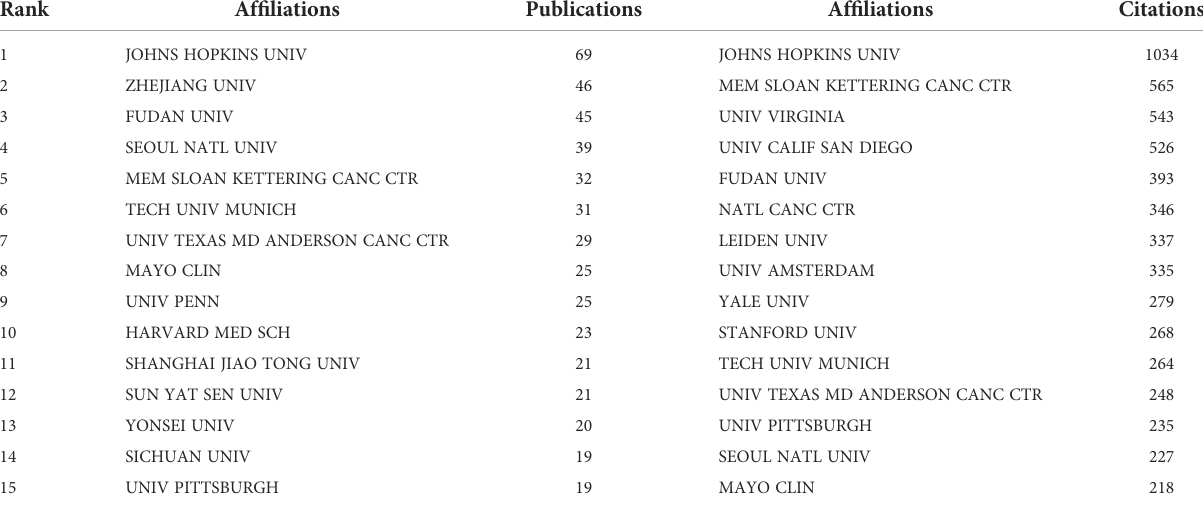
TABLE 2 Top 15 publications and total citations institutions on research of AI in pancreatic cancer. Rank Af fi liations